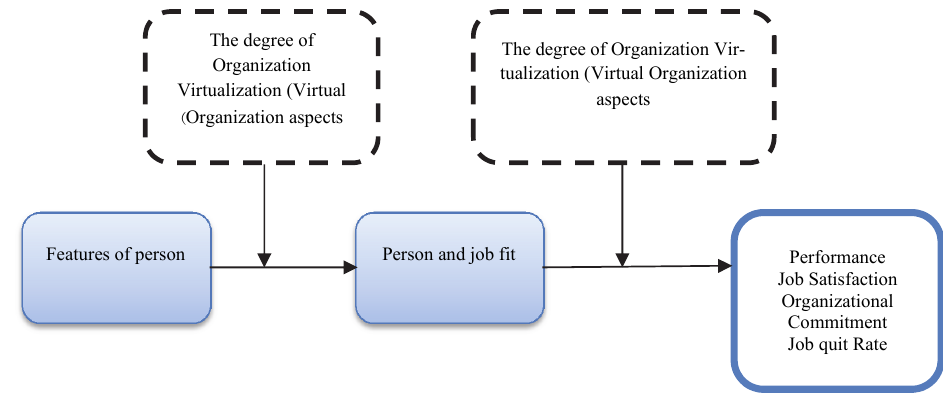
Fig. 1. A model of employee and job fit in the virtual organization (Shin,